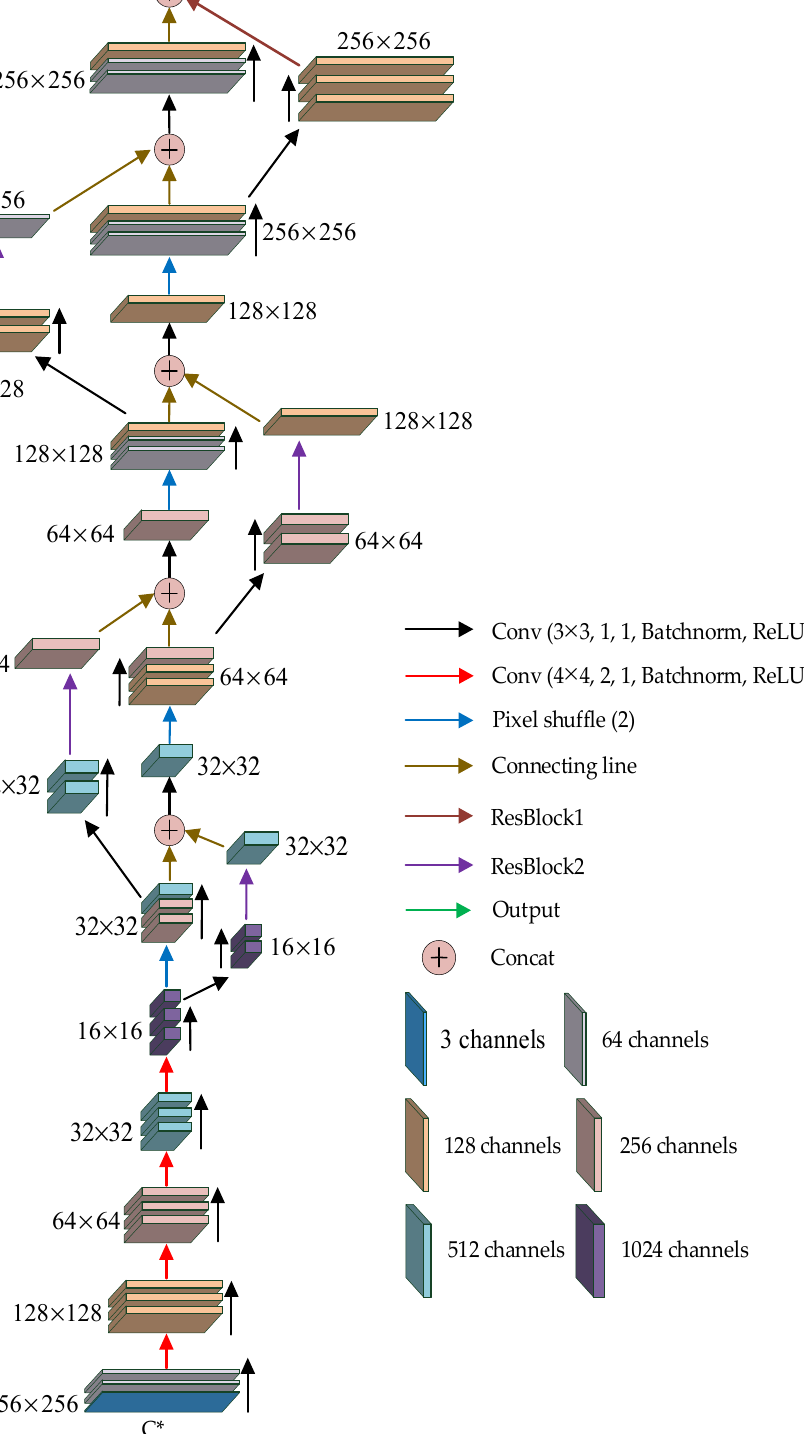
Figure 4. Torch-Net structure (Conv: Convolutional network, Concat: Concatenation operation).